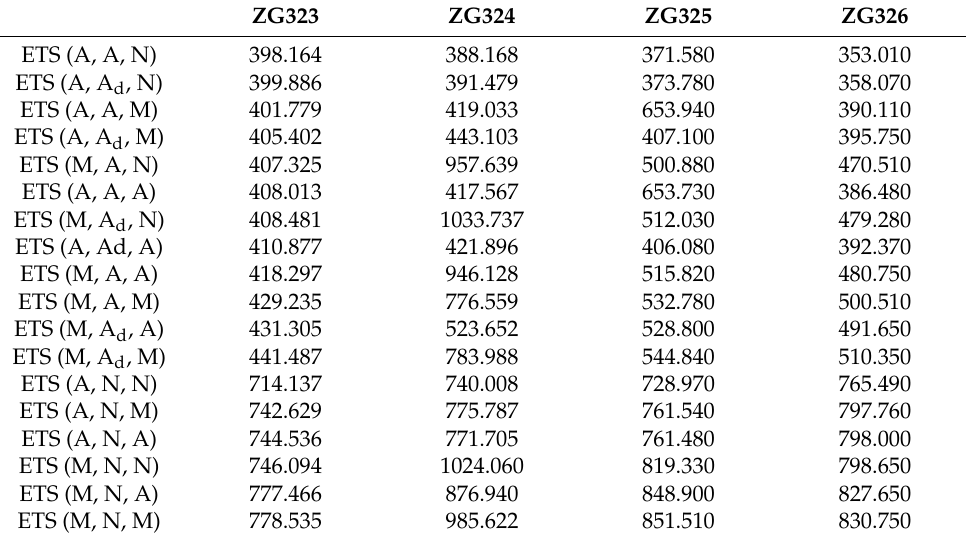
Table 2. The AIC C results of the trend displacement in four GPS stations.